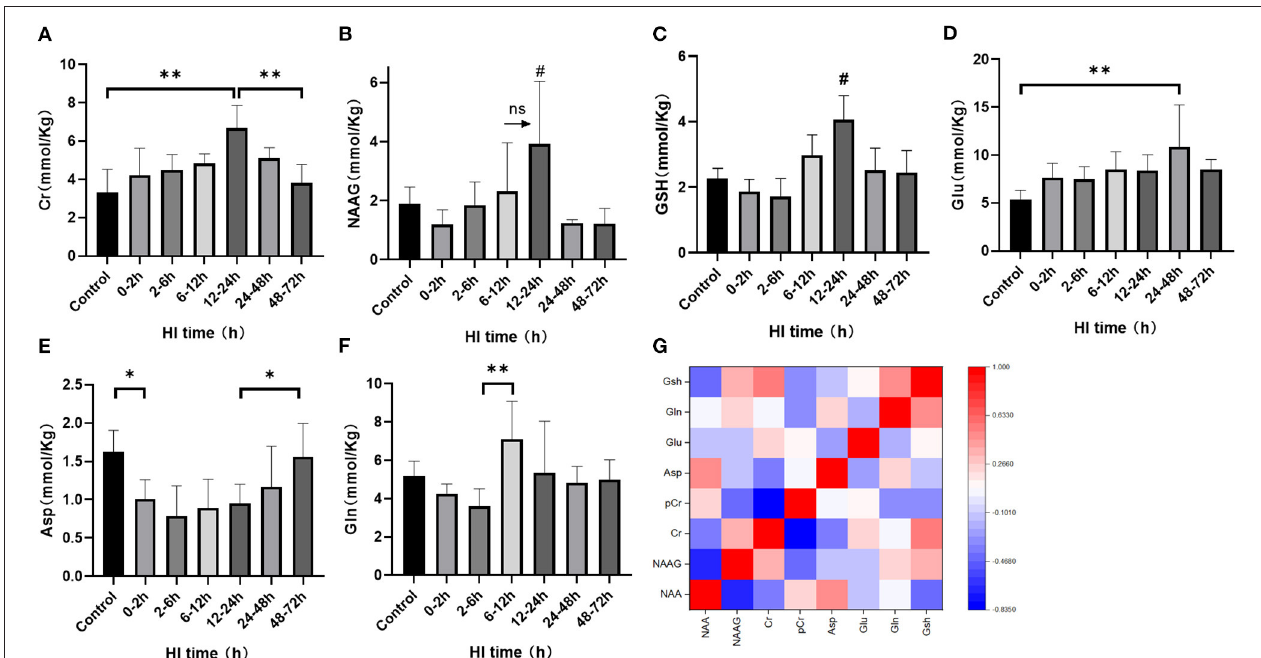
FIGURE 1 | The changes in cerebral metabolites discovered using 1 H-MRS and the correlation heatmap after HI injury. (A–F) Changes in Cr, NAAG, GSH, Glu, Asp, and Gln after HI injury (** P < 0.01, * P < 0.05, ns P > 0.05,# compared with other groups, P < 0.05). Data are expressed as mean ± standard deviation. (G) . Correlation heatmap of cerebral metabolites after HI injury. Red indicates a positive correlation and blue a negative correlation with darker colors suggesting a stronger